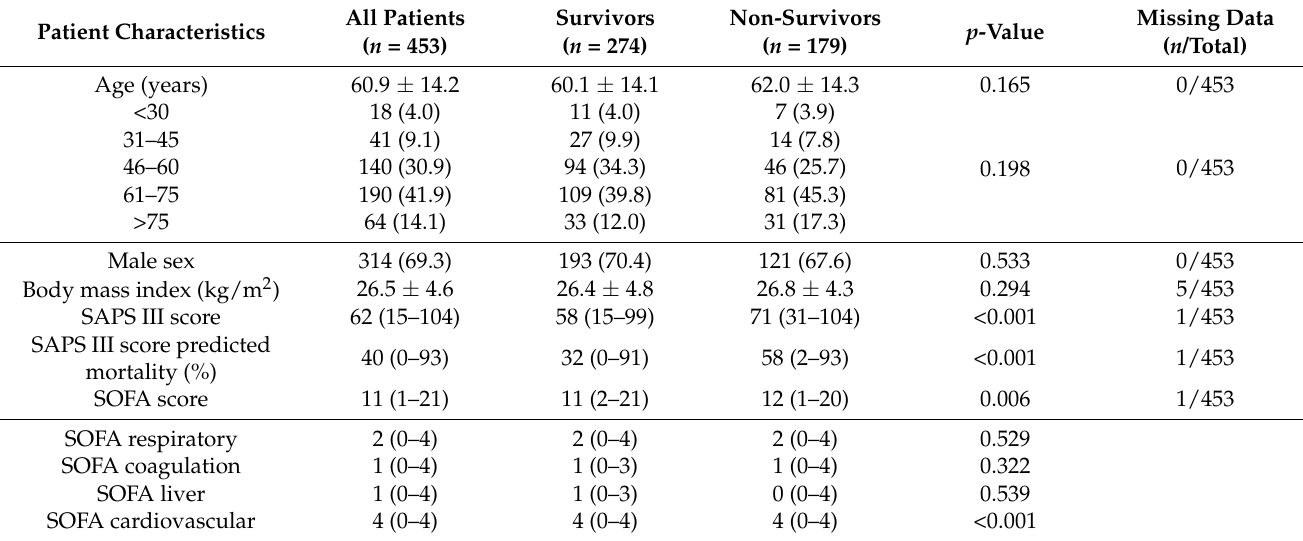
Table 1. Characteristics of the included patients ( n = 453, in-hospital